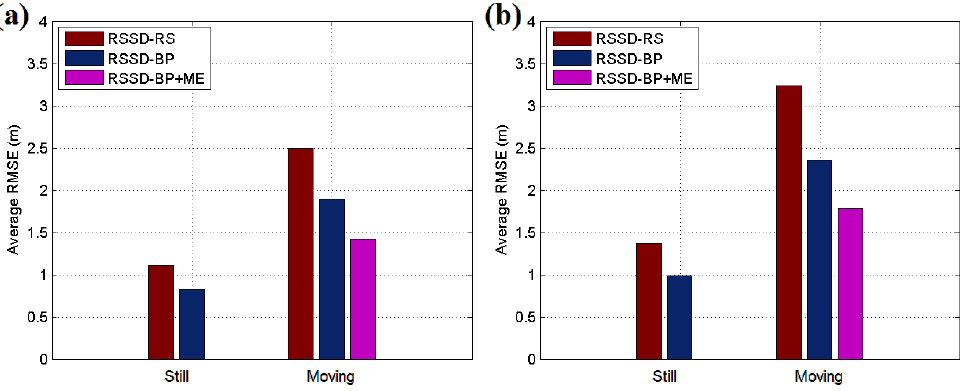
Figure 16. ( a ) Average RMSE of the still and moving targets in testing scenario 1; ( b ) Average RMSE of still and moving targets in testing scenario 2.